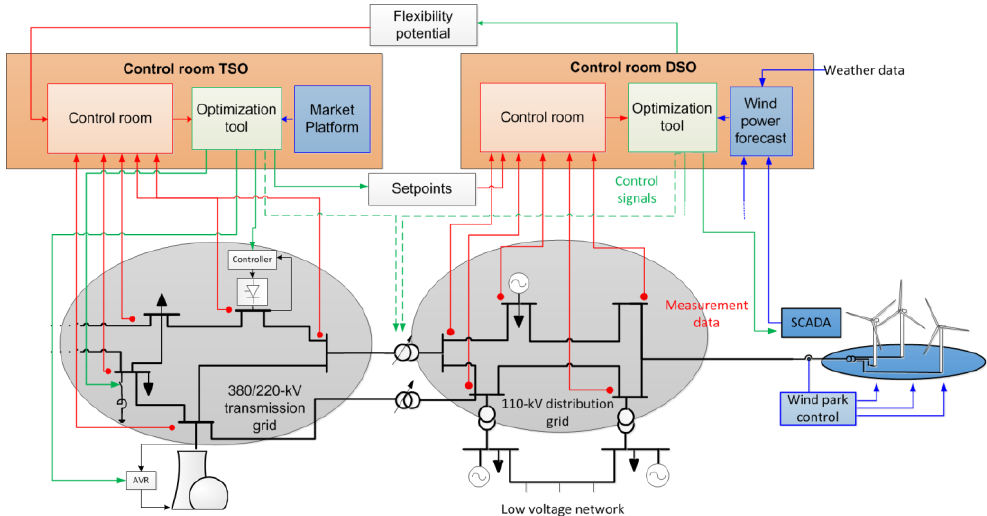
Figure 1. Scheme of the proposed interaction between TSO and DSO for coordinated operation.